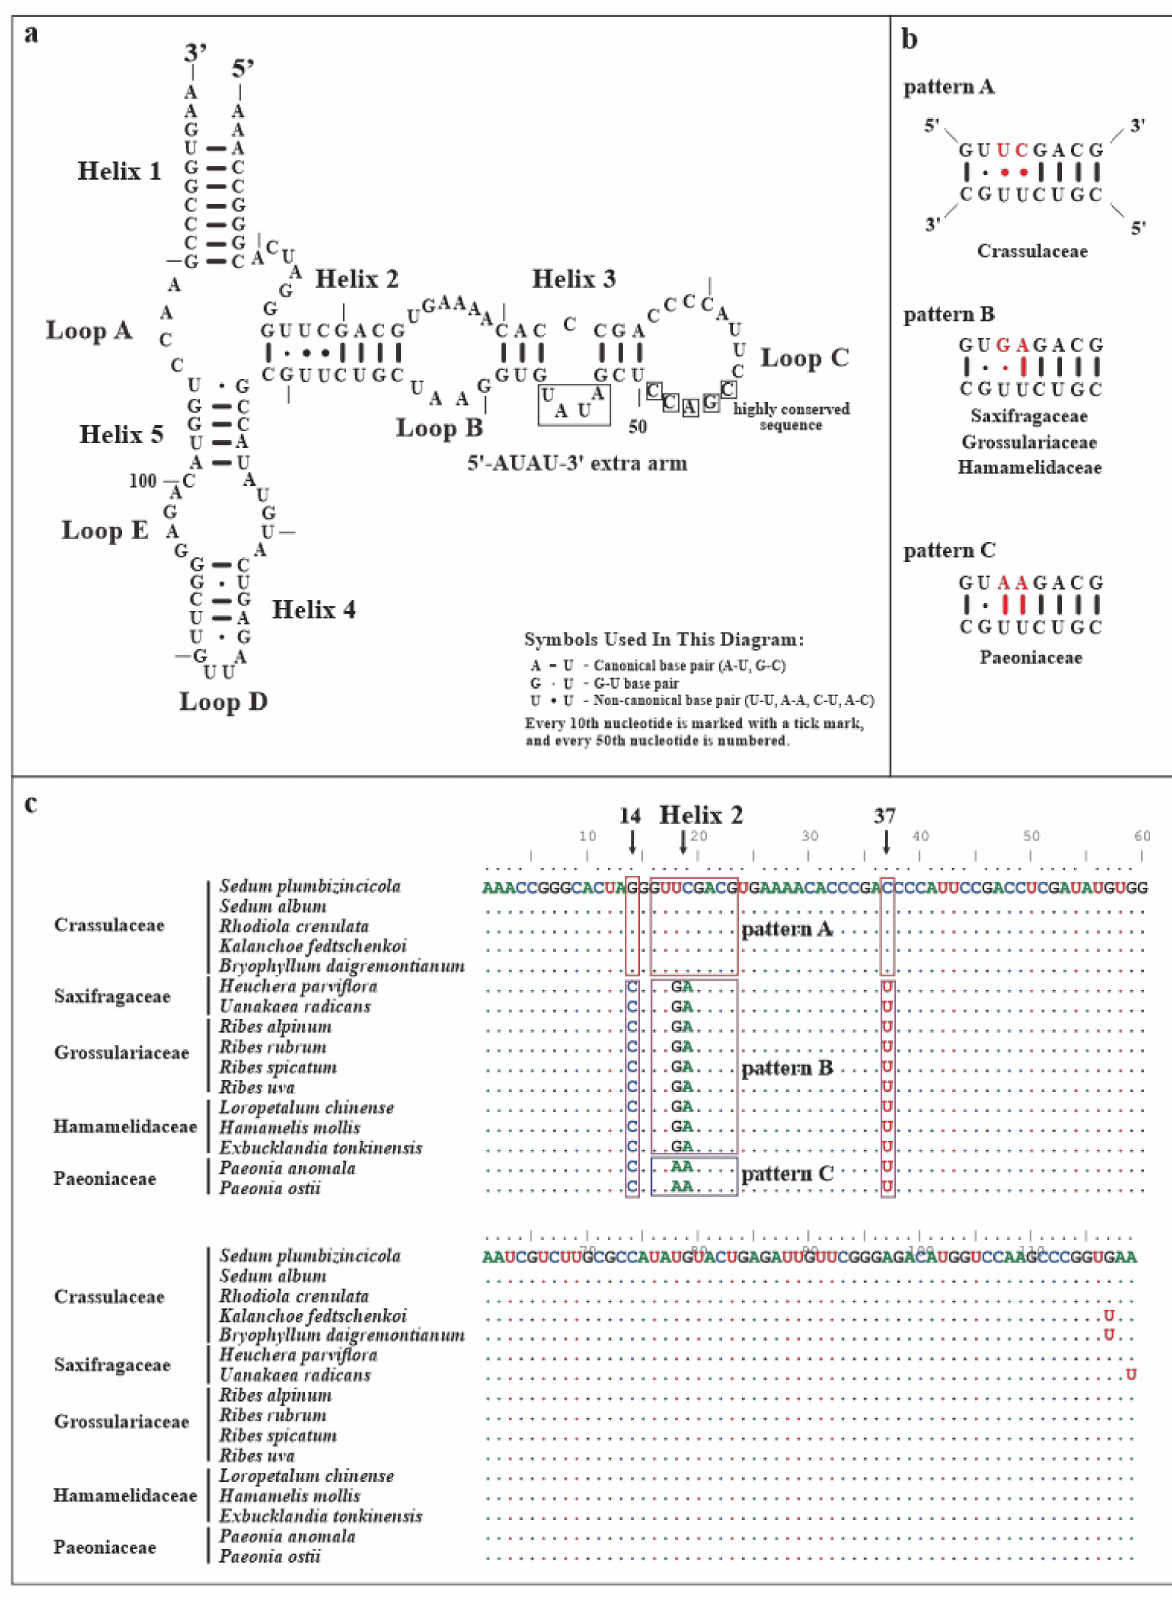
Figure 7. The predicted secondary structures and sequences of 5S mtrRNAs. ( a ) The secondary structures of 5S mtrRNAs of S. plumbizincicola. ( b ) The different structural patterns of Helix 2 within Saxifragales. ( c ) The sequences of 5S mtrRNAs investigated within